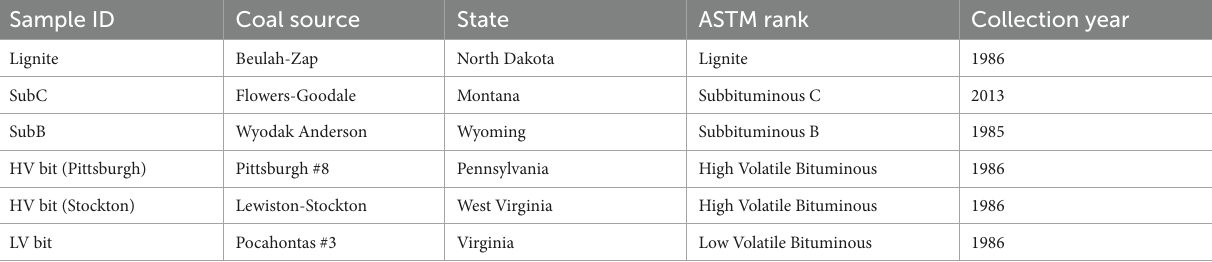
TABLE 1 Coal samples of different ranks used in this study.